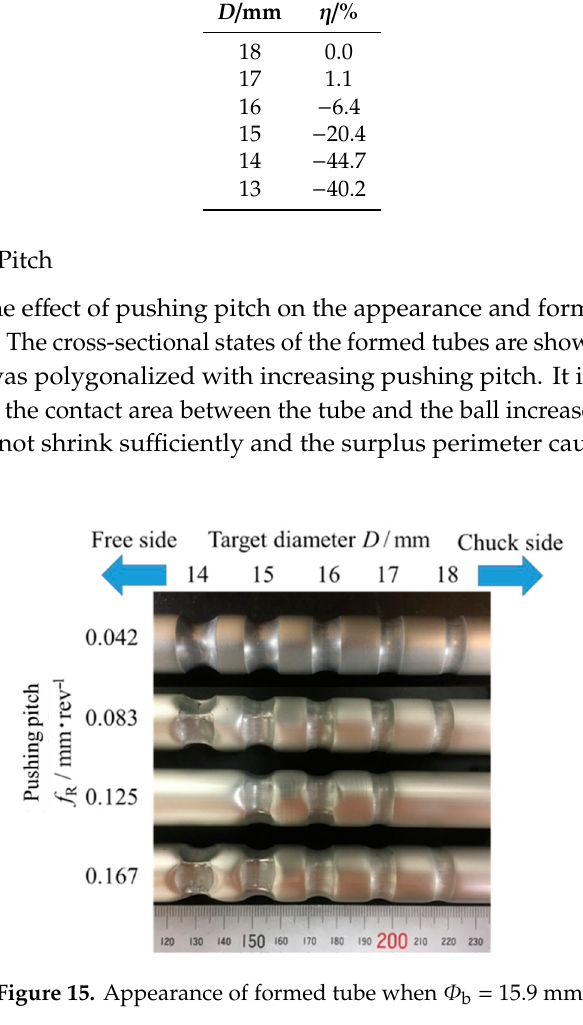
Table 5. Cross-sectional state of the formed